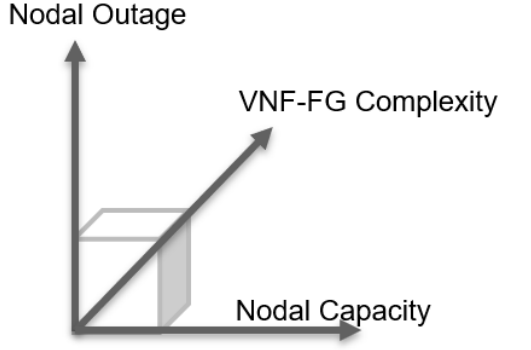
Figure 12. Diversification of the DRL Model.